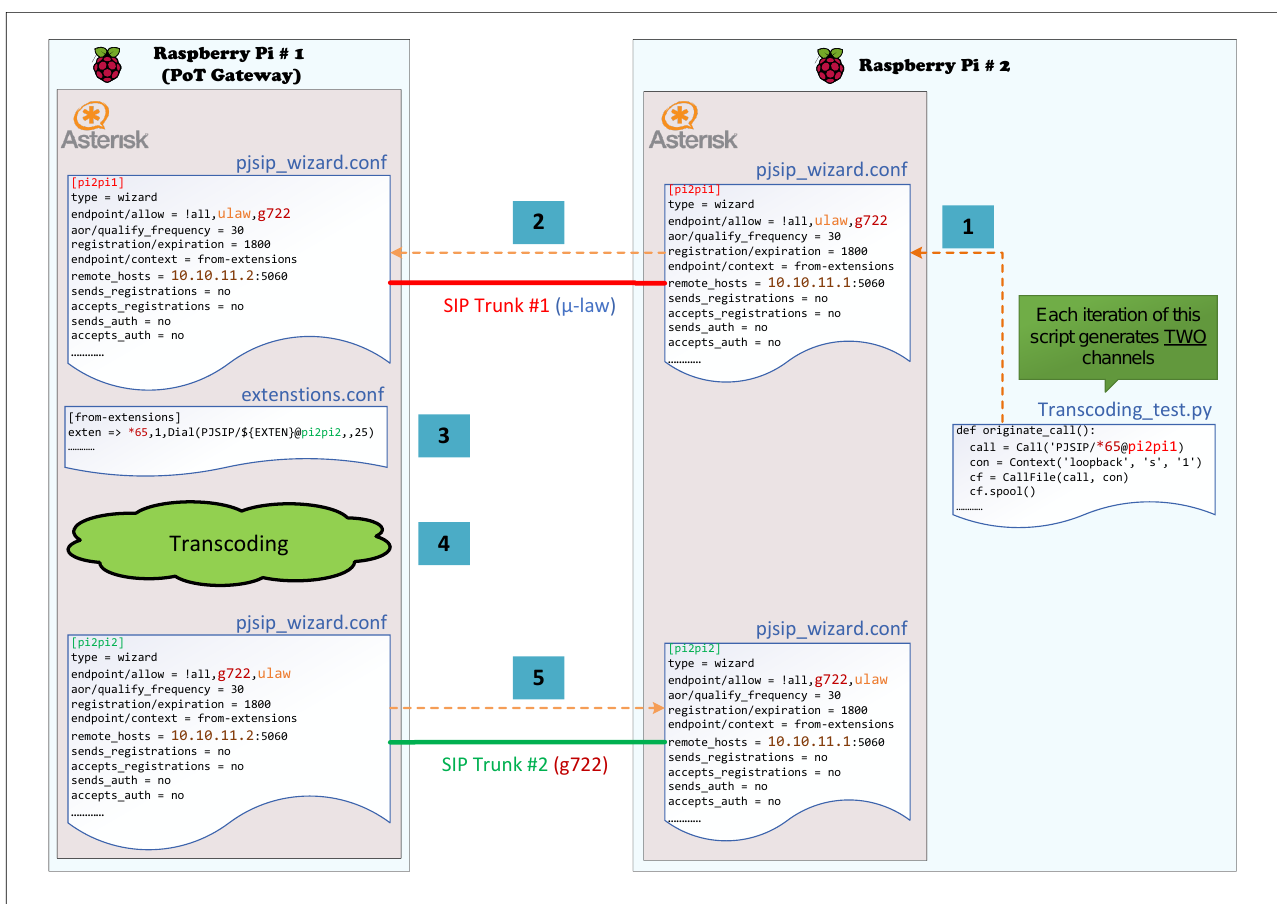
Figure 8. Transcoded VoIP testing